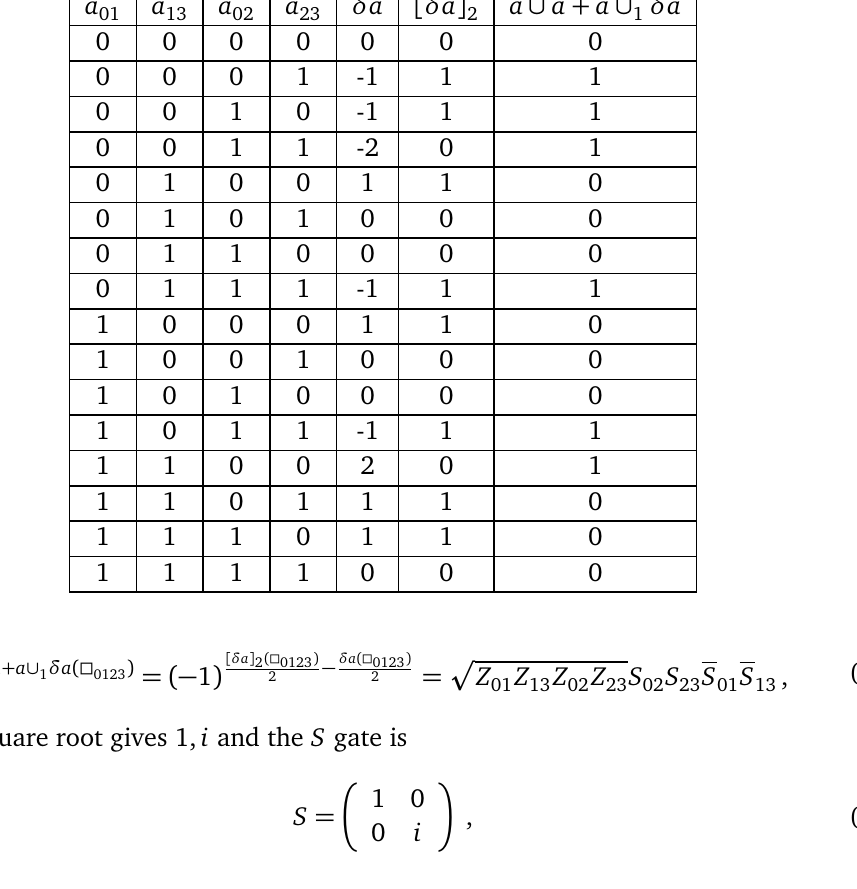
) and verifies that all of , a , a , a 01 13 02 23